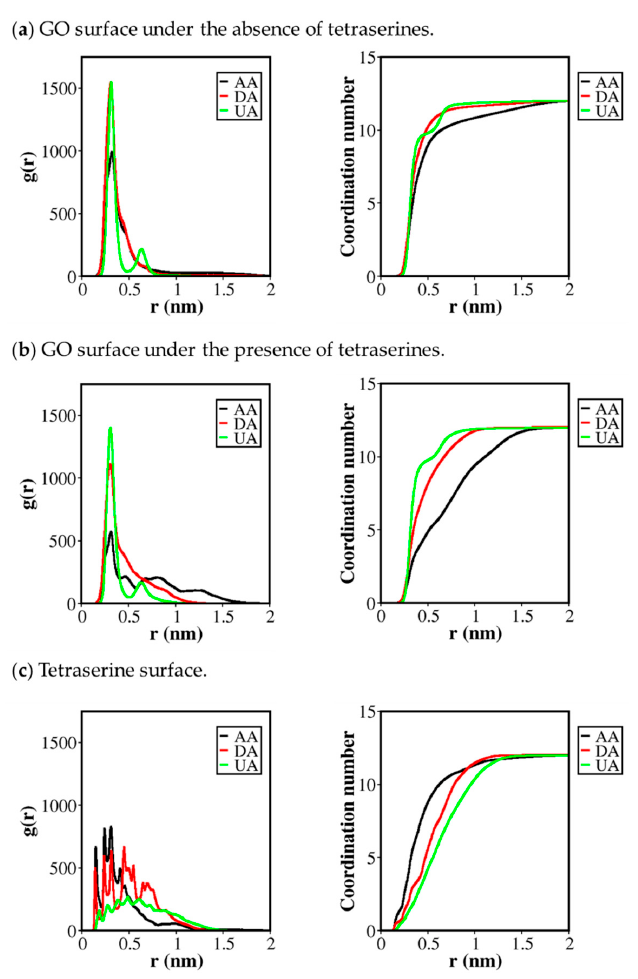
Figure 4. Radial distribution functions of AA/DA/UA analytes ( a ) about the GO surface under the absence of tetraserines; ( b ) about the GO surface under the presence of tetraserines; ( c ) about the tetraserines. Corresponding coordination numbers were also